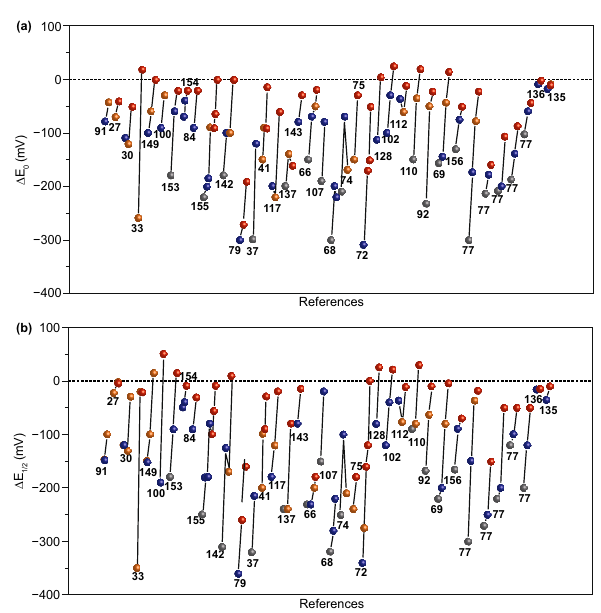
Fig. 10 Comparison results of the ORR activities with their related commercial Pt/C catalyst: a Δ E 0 , b Δ E 1/2 ; the gray, orange, blue, and red balls represent the pristine, defective, heteroatom-doped, and defect-/doping-co-engineered non-metal nanocarbon ORR electrocat- alysts, respectively